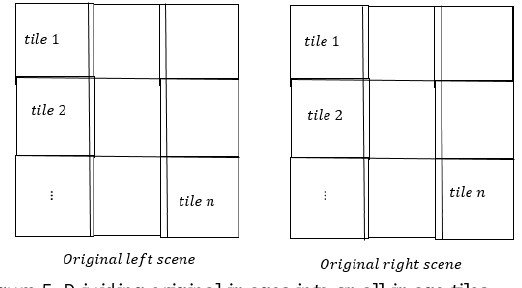
Figure 5. Dividing original images into small image tiles For the image tiles in left image, correspond tile should be found in right image, using affine